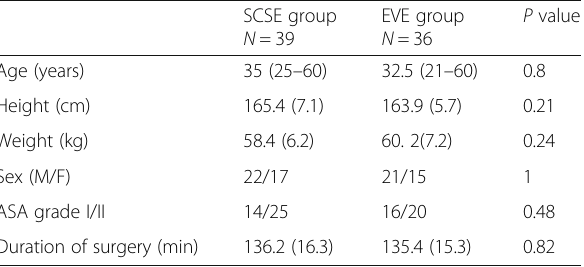
Table 3 Block characteristics and total